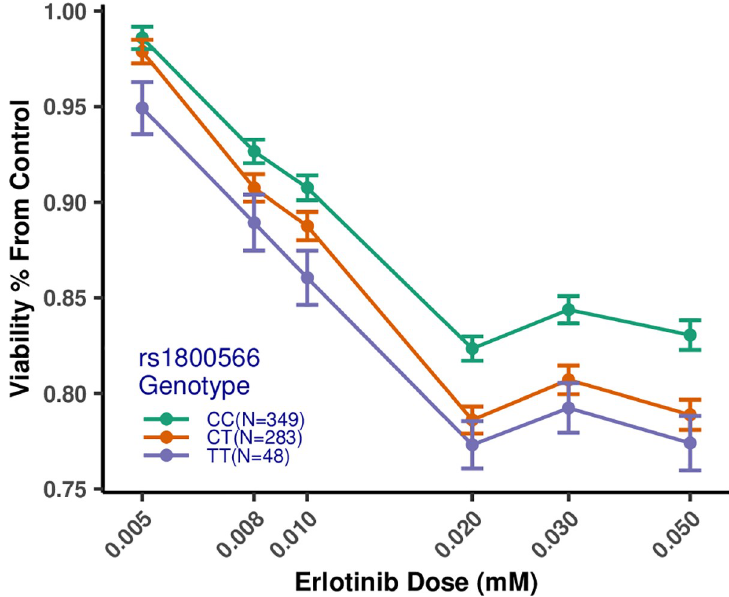
Fig 3. Dose-response profiles for erlotinib stratified by genotype at SNP rs1800566. C is the reference allele, and T is the variant allele at SNP rs1800566. Individuals with the TT (alternate) genotype have lower cell viability than those with the CC (reference) genotype. Heterozygous individuals (i.e., those with the CT genotype) have intermediate cell viability compared to CC and TT individuals. The numbers of individuals for each genotype are: CC—349, CT—283, TT—48. Concentrations are on the log10 scale on the X-axis. Bars represent the standard error of the mean. views of this peak for associations with the drug erlotinib. Fig B in S1 Text shows regional gene plots for the same peak for associations with arsenic trioxide, trametinib, and the paclitaxel